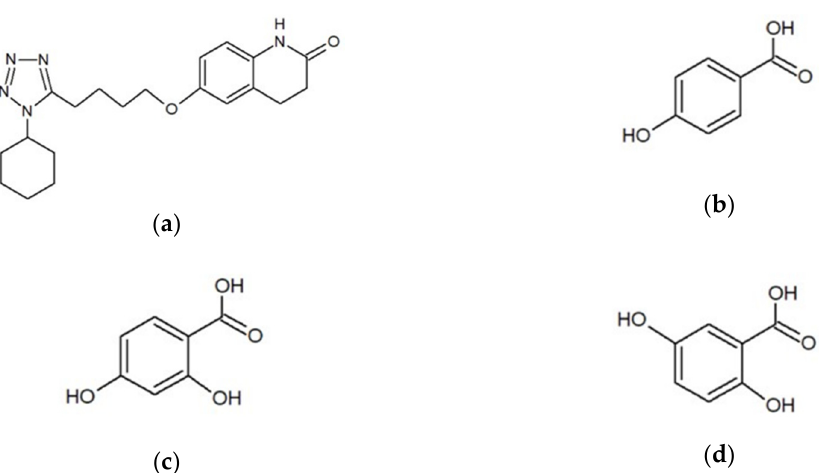
Figure 1. Chemical structures of ( a ) cilostazol (CLZ), ( b ) 4-hydroxybenzoic acid (4HBA), ( c ) 2,4-dihydroxybenzoic acid (2,4DHBA), and ( d ) 2,5-dihydroxybenzoic acid (2,5DHBA).